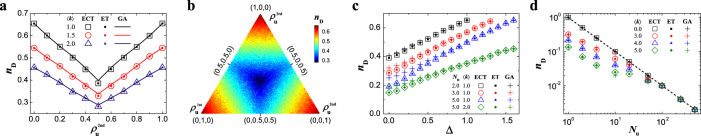
The controllability of networks consisting of a mixture of dynamic units with different orders.(a), nD as a function of the density  of the 2nd-order dynamic unit incorporated with the 1st-order dynamic units. (b), nD as a function of the densities ,  and  of dynamic units associated with different orders. (c), nD as a function of the density heterogeneity, Δ, for a mixture of dynamic units from 1st- to 3rd-order. (d), nD as a function of the number Nu of a mixture of different dynamic units from 1st- to 3rd-order. The number of dynamic units in (a)–(d) is 500 and ER random networks described by structural matrices are used. In (b), the average degree 〈k〉 = 1. The dotted line in (d) is nD = 1/Nu. Each data point is obtained by averaging over 100 independent realizations. (See Supplementary Section 2 and 3 for ET and GA.)